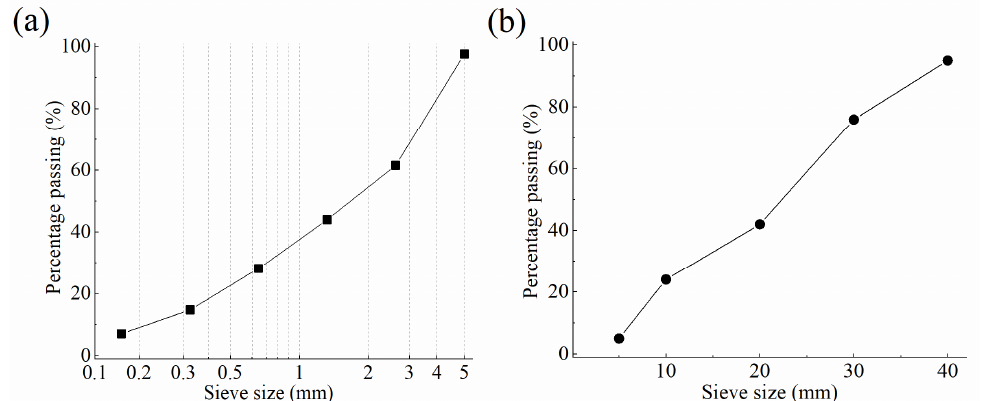
Figure 1. Sieve analysis of ( a ) fine aggregate and ( b ) coarse aggregate used in this study.